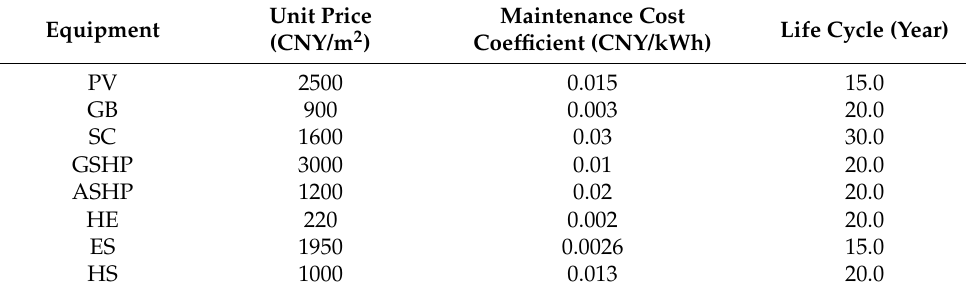
Table 1. Equipment data.